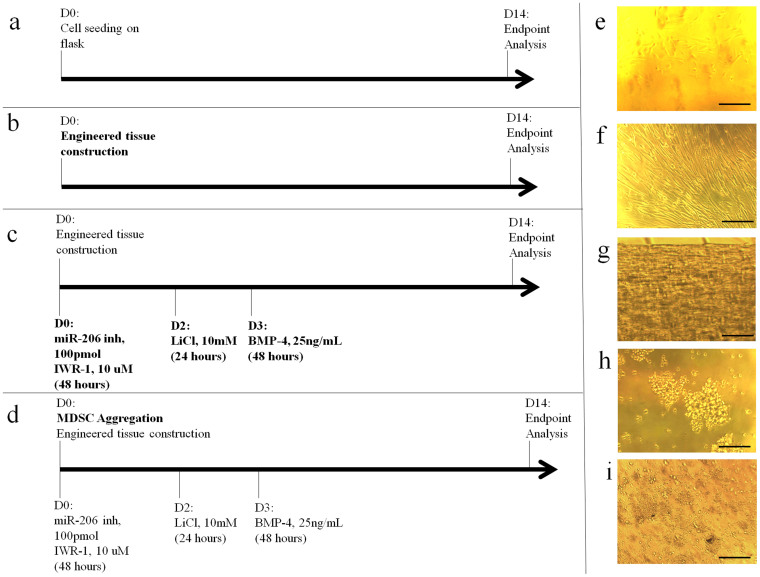
Differentiation of human MDSC.(a) 2D: MDSCs are seeded on a tissue culture flask at high density and allowed to differentiate. (b) AMT: MDSCs are cultured within 3D artificial muscle tissue. (c) 4F-AMT: MDSCs are cultured in 3D artificial muscle tissue and treated with 4 chemical factors. (d) 4F-AG-AMT: MDSC aggregates are cultured in 3D artificial muscle tissue and treated with 4 chemical factors. (e) Undifferentiated MDSCs on tissue culture flask. (f) 2D Differentiated MDSCs at day 14. (g) MDSCs in AMT. (h) MDSC aggregates after 4 hours of rotary suspension culture. (i) MDSC aggregates in AMT immediately after tissue construction. Scale bar indicates 250 μm.